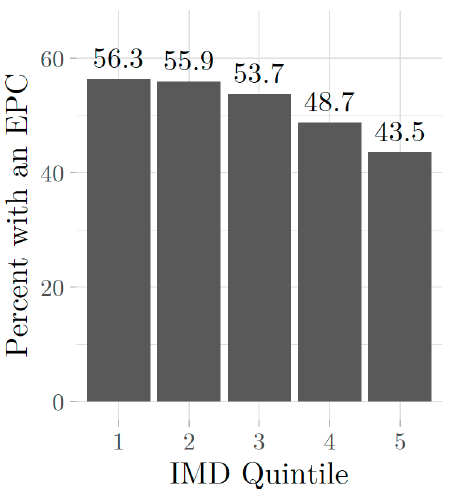
Figure 21. Prevalence of EPCs among SERL Observatory households by IMD quintile.